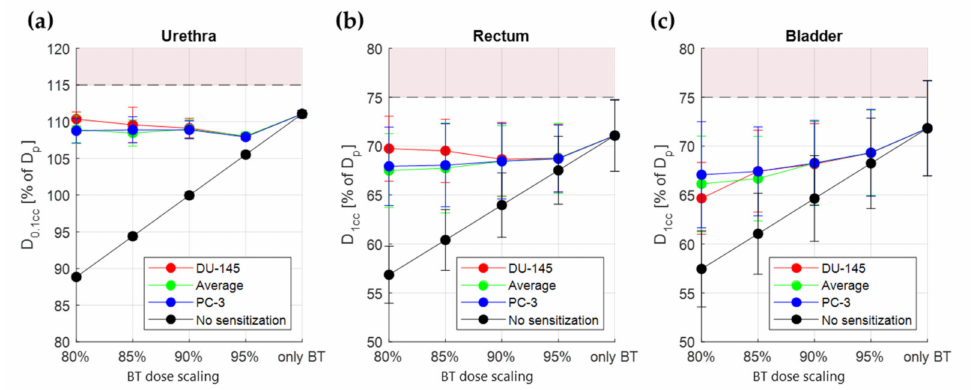
Figure 9. Average values ( ± standard deviation) over 10 simulated patients of the TBT TP parameters for different scaling of the original dose: urethra D 0.1 cc ( a ), rectum D 1 cc ( b ), and bladder D 1 cc ( c ). The different colors correspond to the plans generated based on different thermoradiotherapeutic values (red for DU-145, blue for PC-3, and green for the average between DU-145 and PC-3). The black line shows the lowest possible value, assuming no radiosensitization of the normal tissue. The horizontal dashed lines correspond to the constraint limit for each criterion. The red areas correspond to constrained values for each